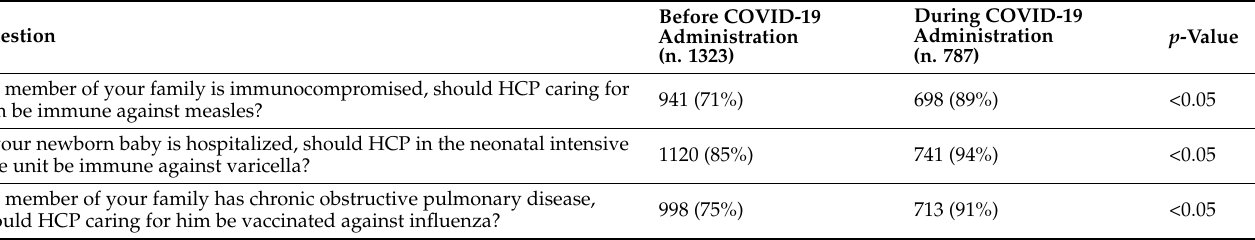
Table 4. HCP’s attitudes regarding mandatory vaccination for HCP using a personalized